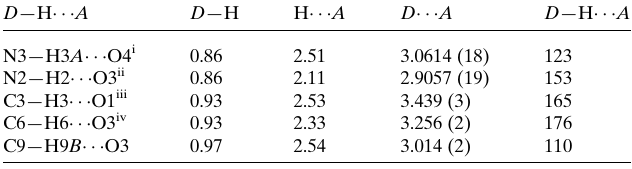
Table 1 Hydrogen-bond geometry (A˚ , (cid:2) ).